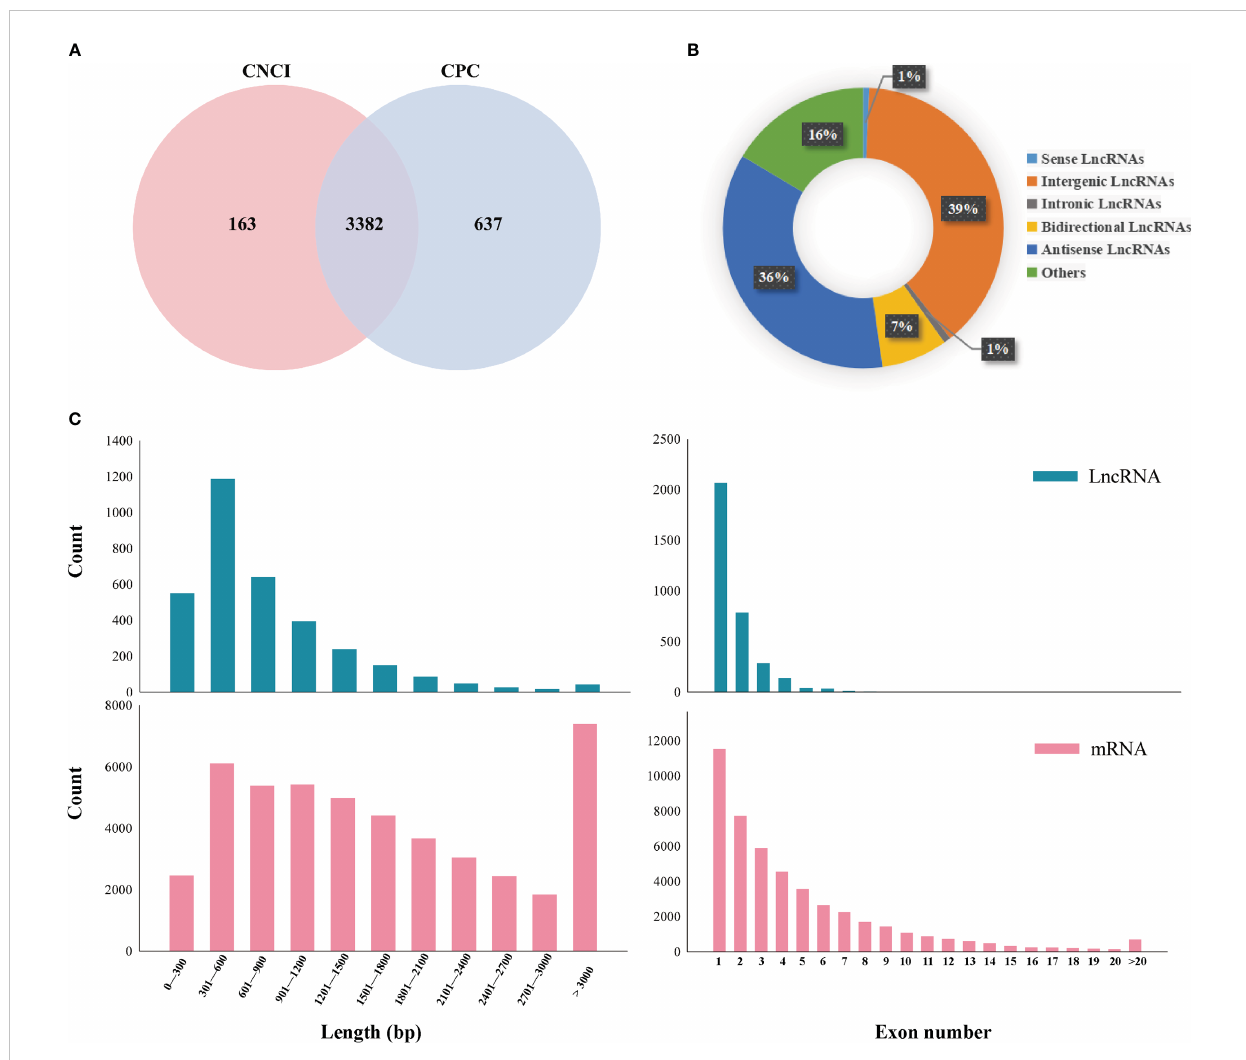
FIGURE 2 Identi fi cation and characterization of lncRNAs with different plumule-vernalization treatments. (A) CNCI and CPC software performed Venn map analysis on the identi fi ed lncRNAs. (B) Proportions of different kinds of lncRNAs. (C) Comparison of exon numbers and transcript lengths between lncRNAs and